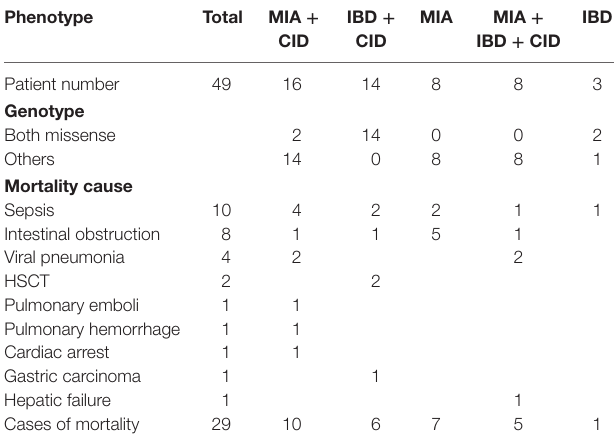
TaBle 2 | Mortality and mutation patterns associated with the five phenotypes in patients with TTC7A mutations. Phenotype